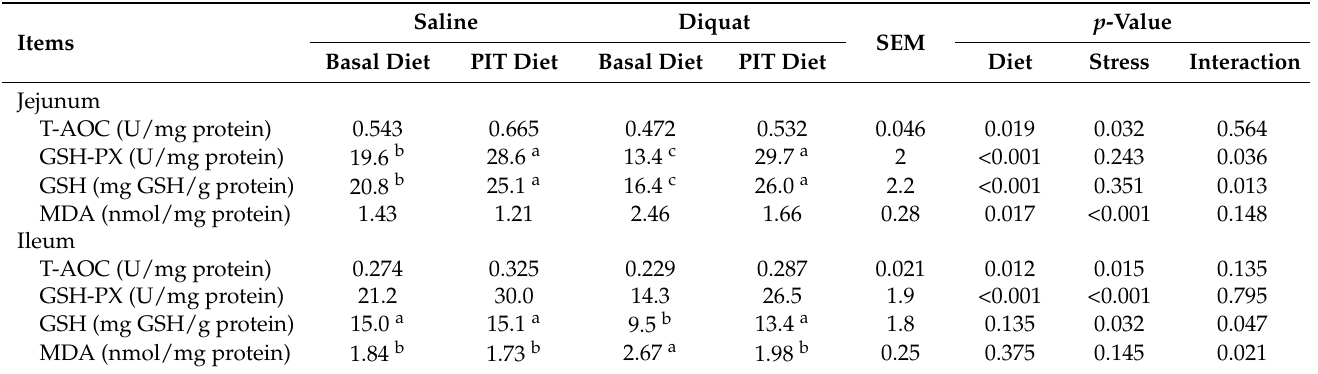
Table 6. The intestinal mucosal antioxidative capacity of the piglets fed polyphenols sourced from Ilex latifolia Thunb. (PIT) diets under oxidative stress.